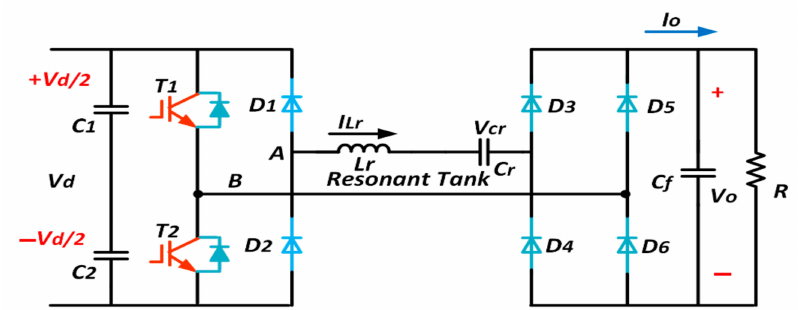
Figure 24. SRC half-bridge configuration [103].